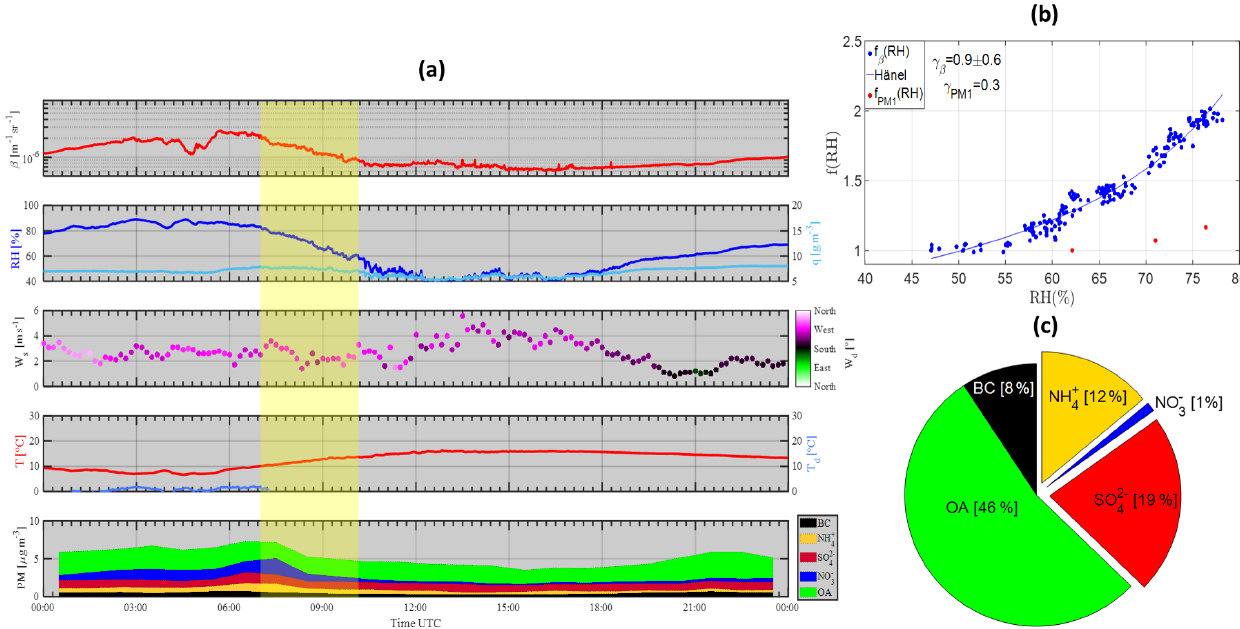
Figure 2. Case 3 on 25 June 2013: (a) time series of β (relative humidity, RH; absolute humidity, q ; wind speed, W s ; wind direction, W d ; temperature, T ; dew point temperature, T d ) and PM 1 chemical species concentration according to the legend; (b) PM 1 -related f PM and β -related f β ( RH ) ; and (c) pie chart of the chemical composition. Panels (b) and (c) are measured for the hygroscopic event time window. The highlighted region in yellow (from 07:17 to 10:17UTC) represents the time window when the aerosol hygroscopic growth is evaluated.